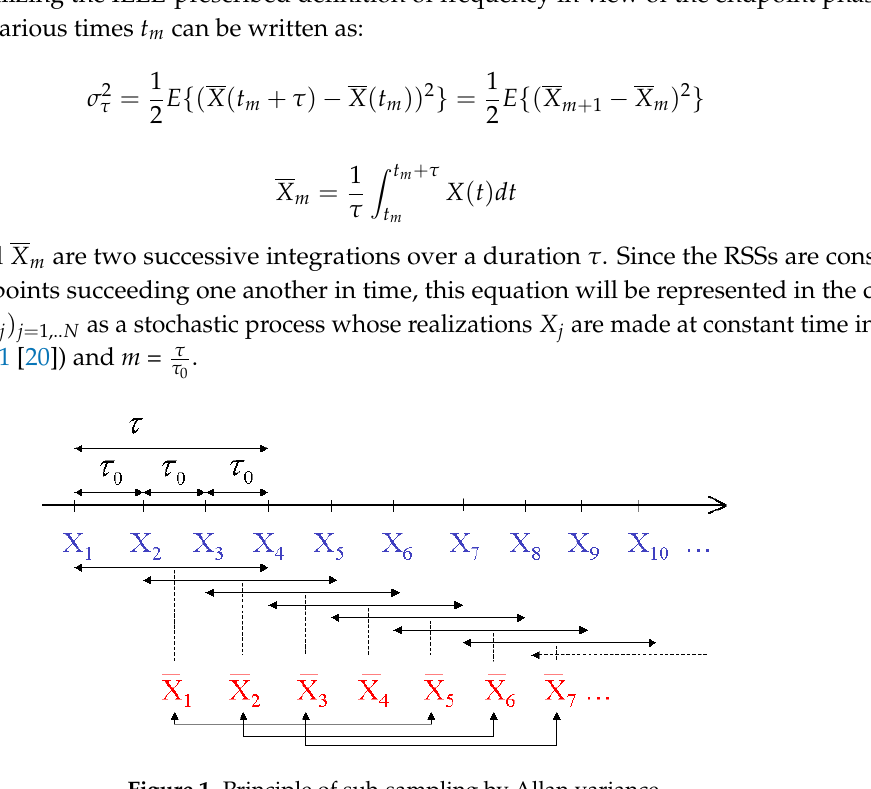
Figure 1. Principle of sub-sampling by Allan